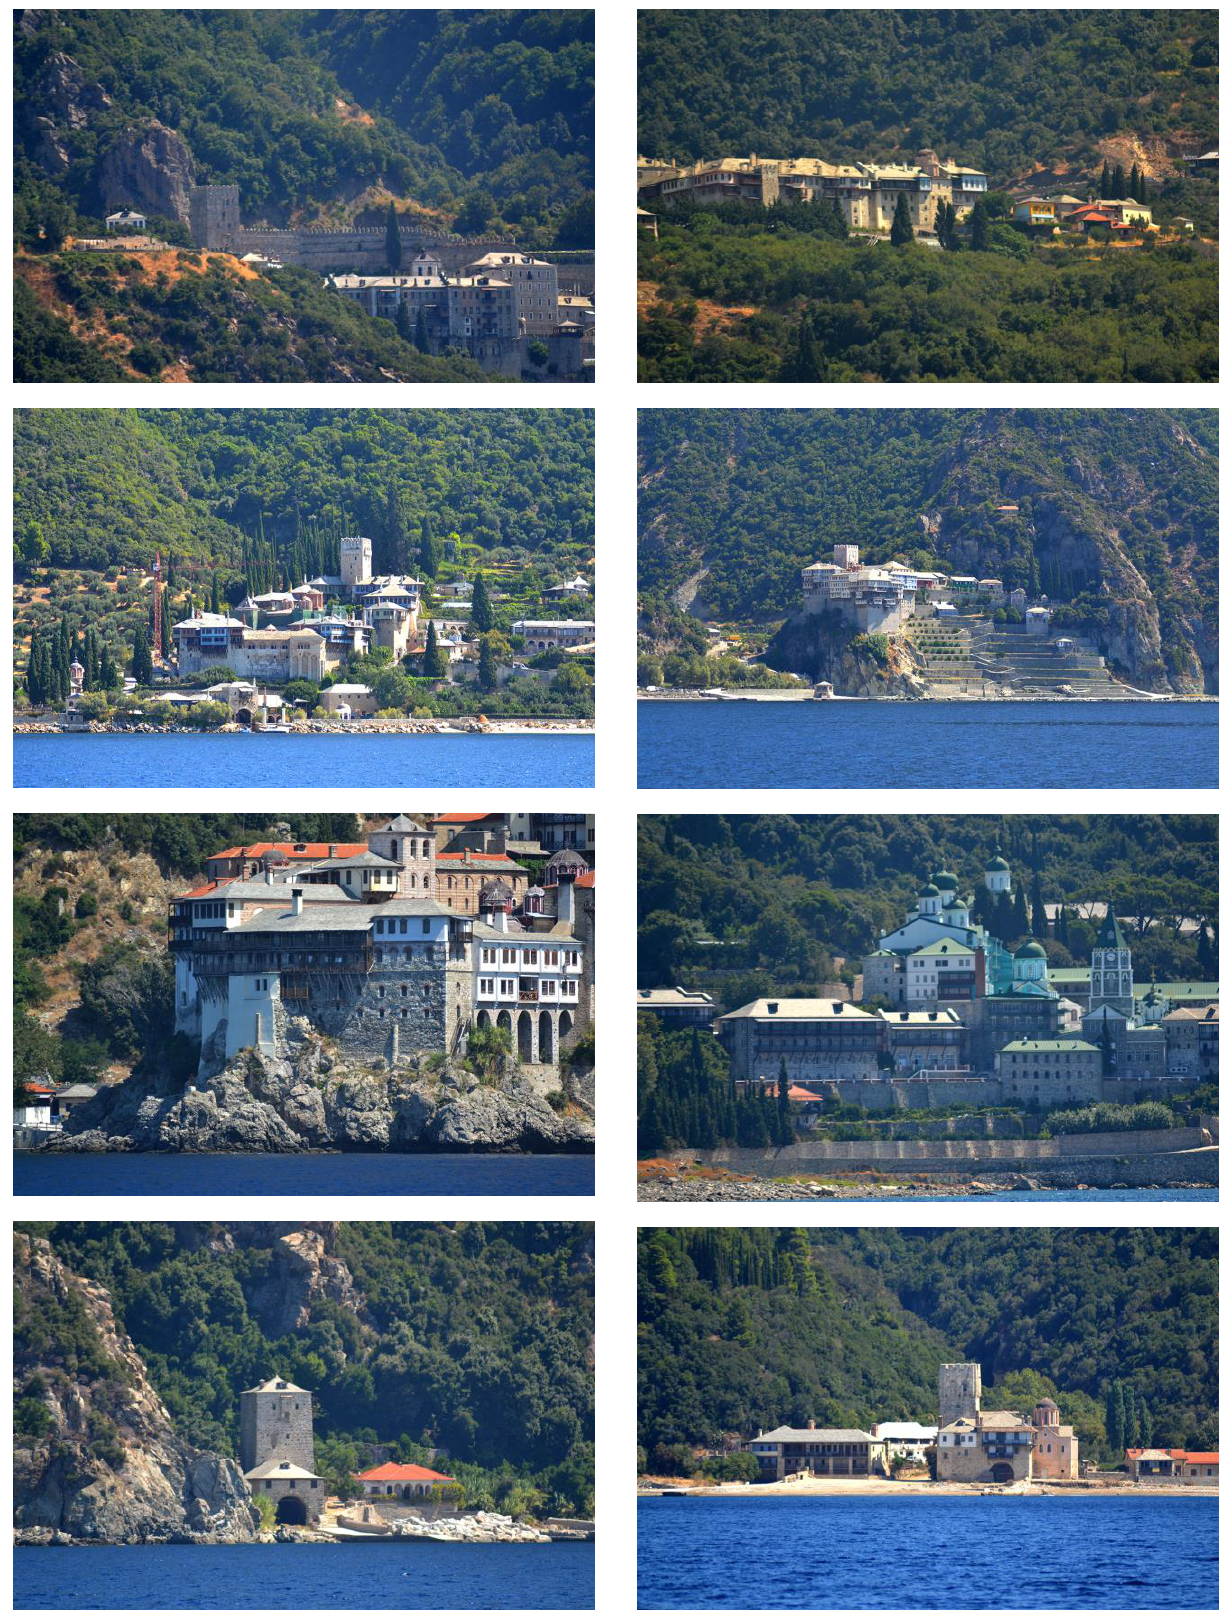
Figure 1 . Photographic documentation of the Monasteries from the sea made in July